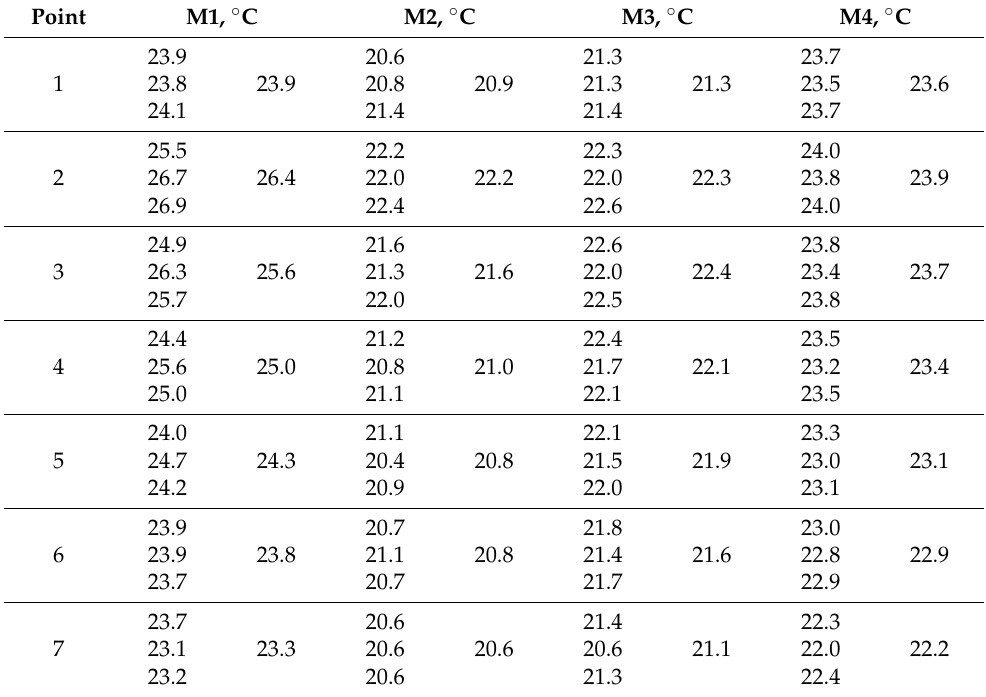
Table 3. The temperature distribution on the front side briquette surfaces in the characteristic